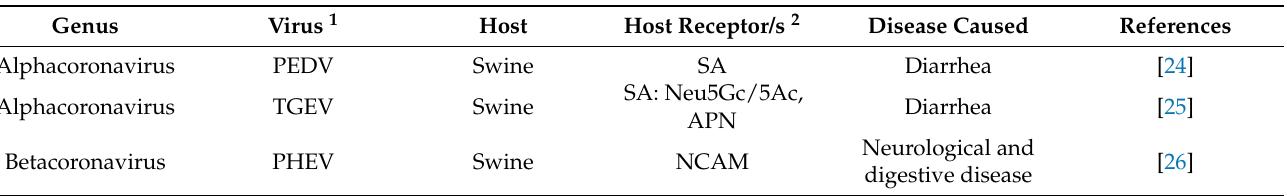
Table 1. Veterinary and medically important coronaviruses, their hosts and host receptors, and diseases they